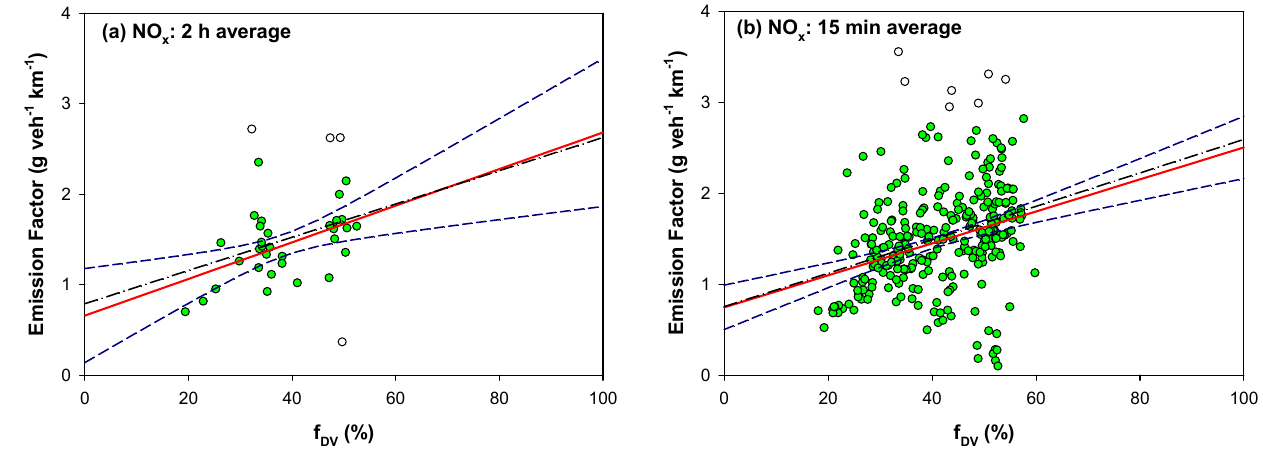
Figure 1. Comparison of simple linear regression of NO x emission factor vs. diesel vehicle fraction for data averaged over ( a ) 2 h and ( b ) 15 min. The black dash-dotted line shows non-robust regression over all data points. The red solid line shows robust regression excluding the outlier (unfilled symbols) data points. The blue dashed lines indicate 95% coincidence intervals for the robust regression.